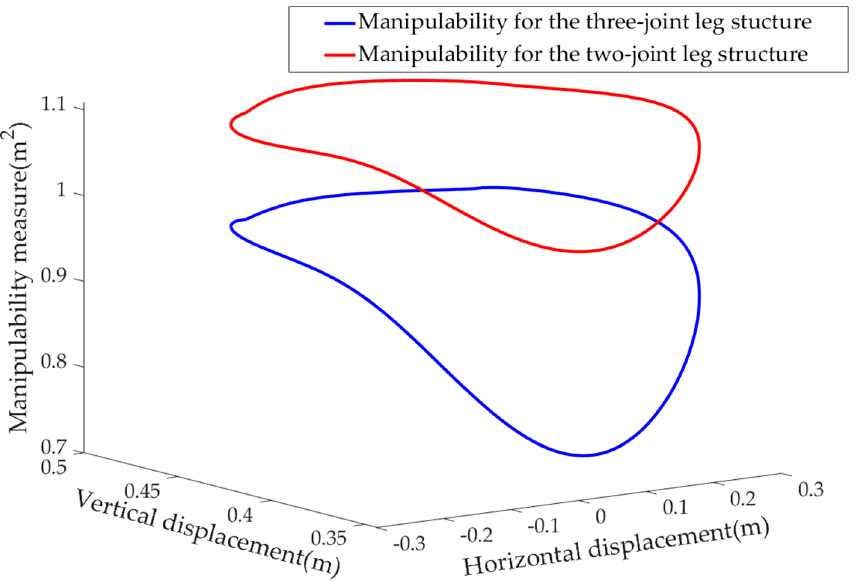
Figure 2. Manipulability for the three-joint and two-joint leg structure.